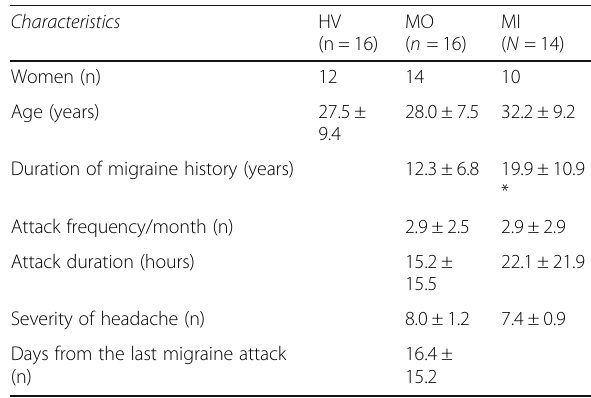
Table 1 Demographic and clinical features of healthy volunteers (HV) and migraine patients without aura between (MO) and during (MI) the attacks. Data are expressed as